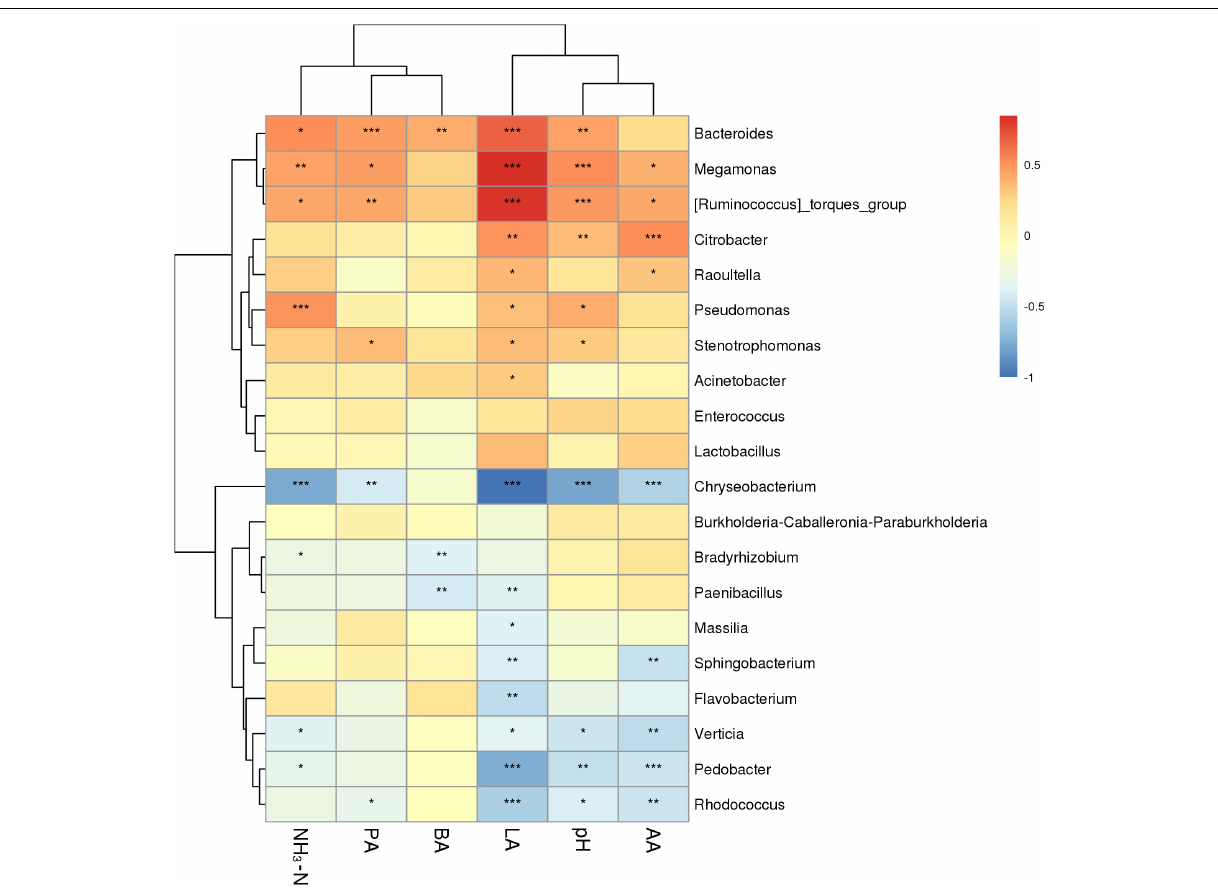
quality reminded us ensiled directly was not the suitable way for P. sinese